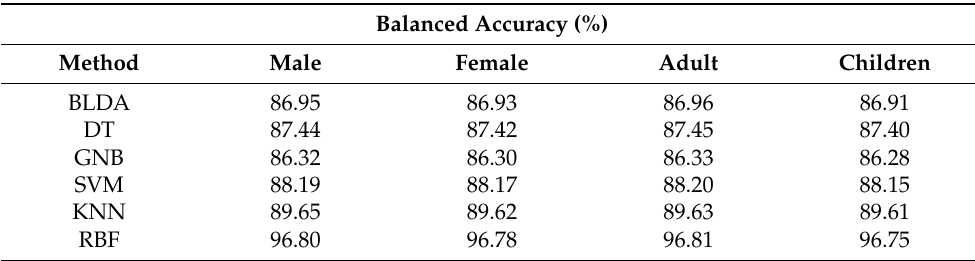
Table 4. Values of balanced accuracy of the machine learning models and the proposed method implemented for different types of patients and healthy